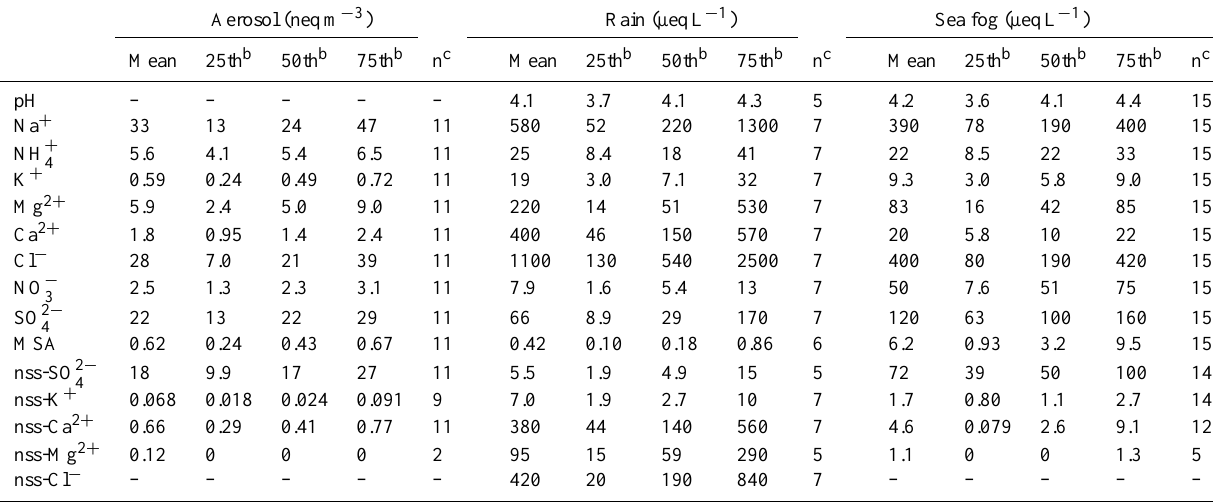
Table 1. Mean, 25th, 50th, and 75th percentile concentrations of major ionic species in aerosols ( n = 11), rainwater ( n = 7), and sea fog water ( n = 15) collected over the subarctic western North Pacific during the cruise a .